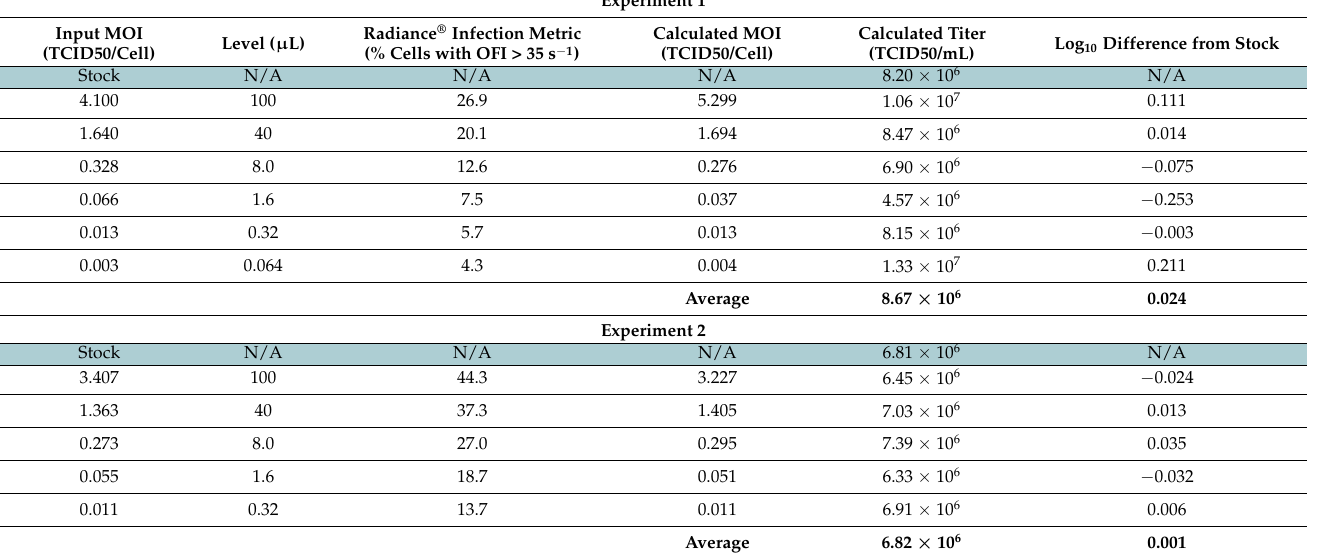
Table 3. Calculated Potency Values for MV Cell Infectivity Assay Samples. Table detailing the Radiance infection metric, Calculated MOI, and Calculated Titer based on the correlation between the LFC data and Input MOI for each cell infectivity experiment. Finally, the average log 10 difference between the stock titer and calculated titer for each sample MOI as well as the average for all points in a given experiment are given in the final